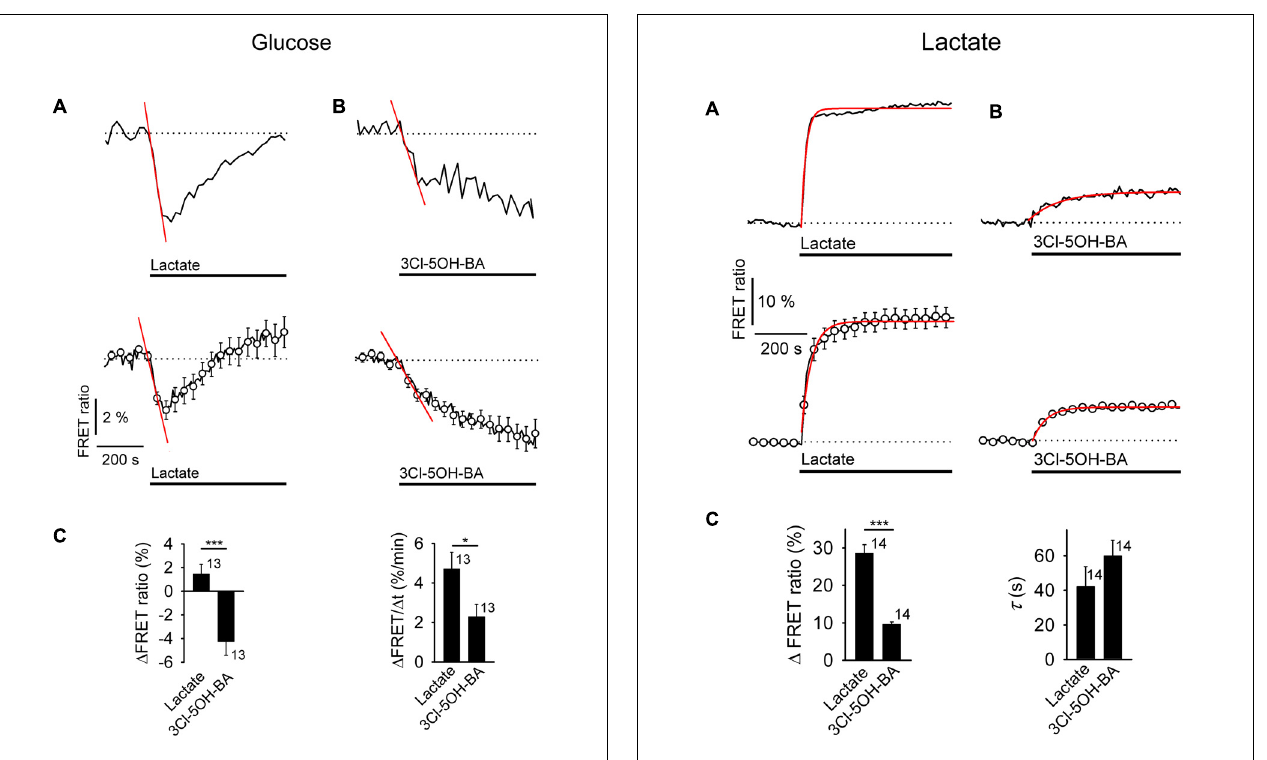
FIGURE 4 | Application of L -lactate and 3Cl-5OH-BA decreases [glucose] i in astrocytes. (A,B) Representative (above) and mean time-course (below) of FLII 12 Pglu-700 µδ 6 FRET ratio signal, reporting [glucose] i , upon the addition of (A) L -lactate (20 mM) and (B) 3Cl-5OH-BA (0.5 mM). Data are expressed as the percentages of the FRET ratio signals (EYFP/ECFP) relative to the baseline ratio values. The initial rate of change in [glucose] i was determined by fitting the regression lines to the signal decreases; (cid:49) FRET (%) = – k (%/min) × (cid:49) t (min), where t is the time and the k –slope is the initial (cid:49) FRET decline: k ( A , above ) = 4.94 ± 0.28 %/min, k ( A , below ) = 2.90 ± 0.36 %/min, and k ( B , above ) = 2.32 ± 0.29 %/min, k ( B , below ) = 1.05 ± 0.11 %/min. Note that the addition of L -lactate transiently decreased the FRET ratio, while the 3Cl-5OH-BA persistently decreased the FRET ratio. Each data point represents the mean ± s.e.m. (C) Mean changes in the FRET ratio ( (cid:49) FRET ratio; left) and initial rates in the FRET ratio decrease ( (cid:49) FRET/ (cid:49) t ; right) upon L -lactate and 3Cl-5OH-BA stimulation. Numbers adjacent to the bars depict the number of cells analyzed. Data shown are in the format of the mean ± s.e.m ( ∗ P < 0.05, ∗∗∗ P < 0.001). Data for every set of experiment was acquired from at least two different animals.